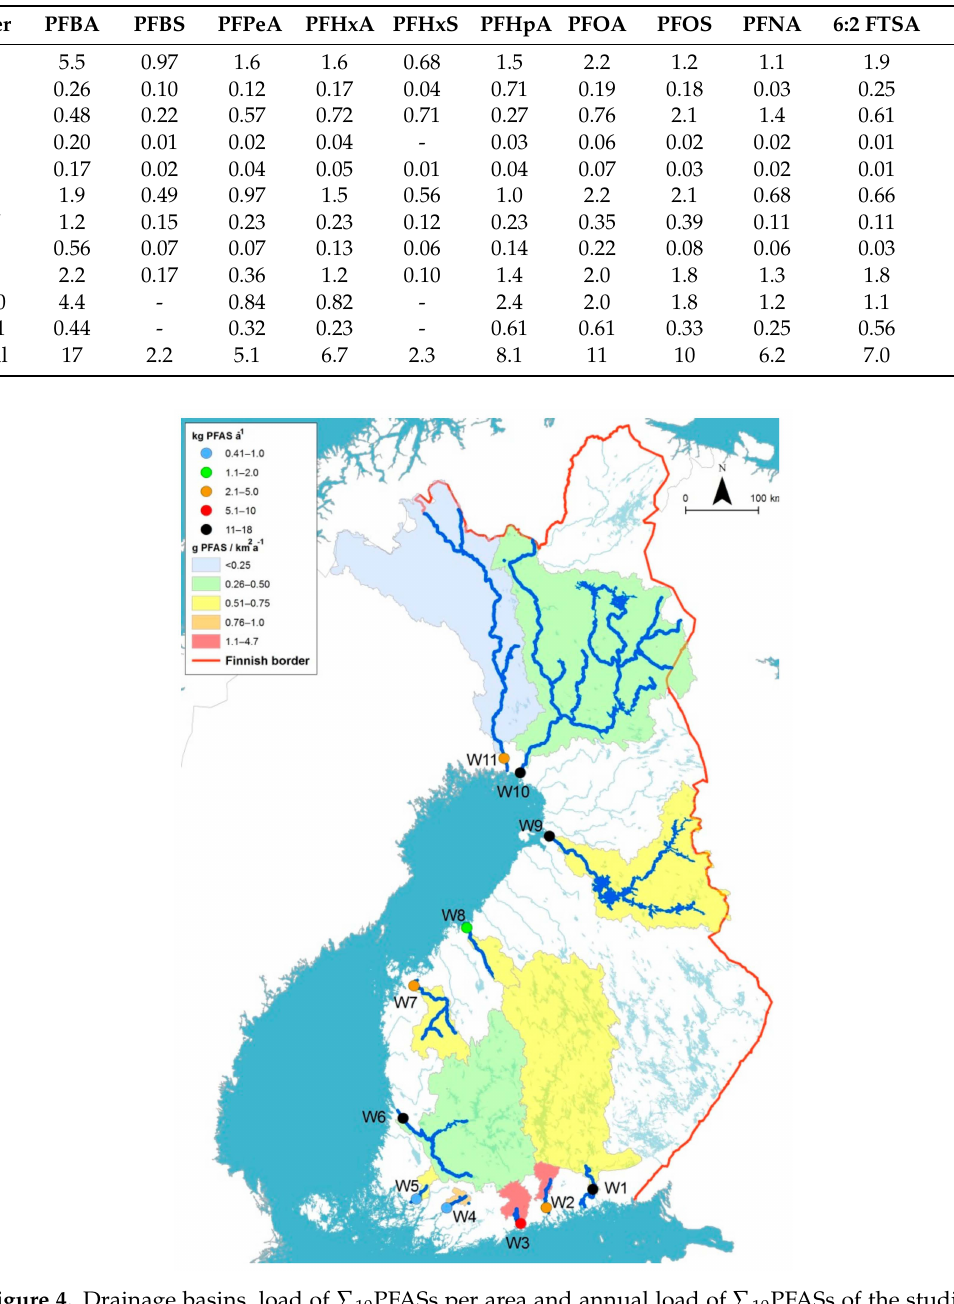
Figure 4. Drainage basins, load of rivers. (Background map by HELCOM and Finnish Environment